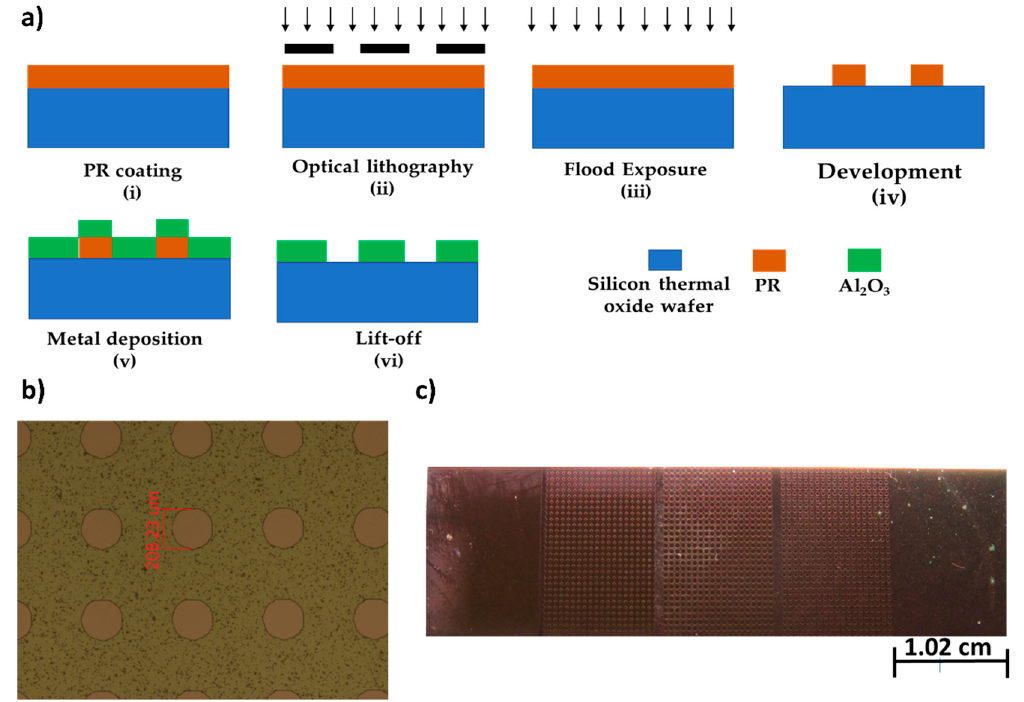
Figure 2. ( a ) Fabrication process flow ( b ) Microscopic view of fabricated patterns ( c ) Image of sample